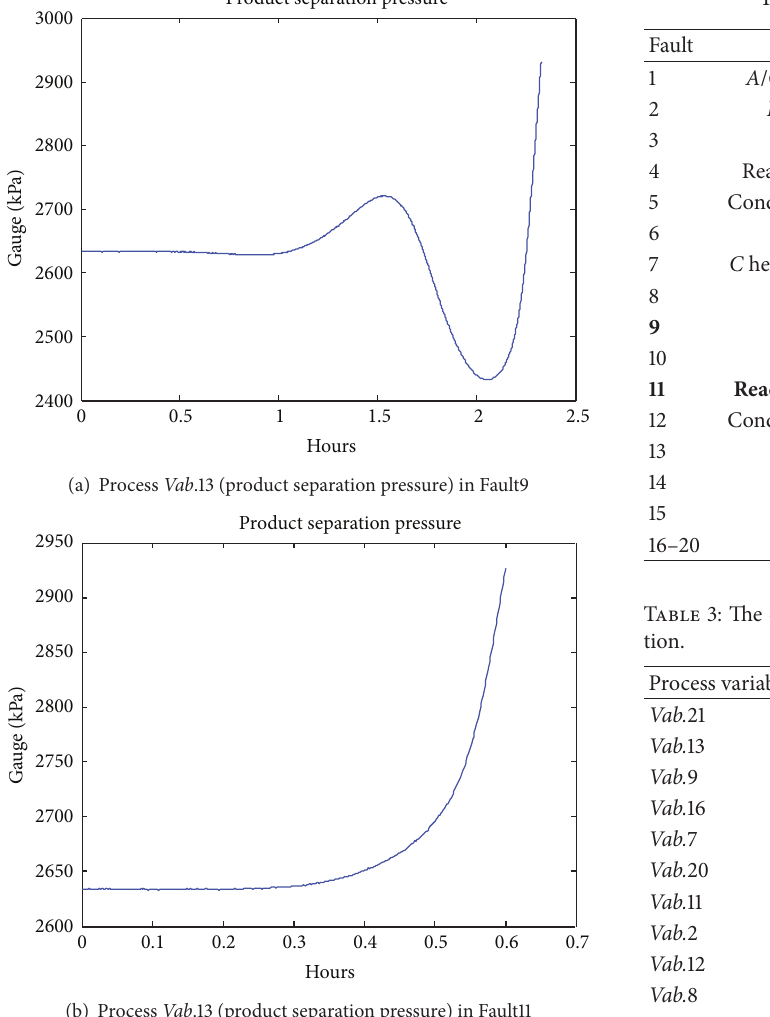
Table 2: State distribution in TE process.